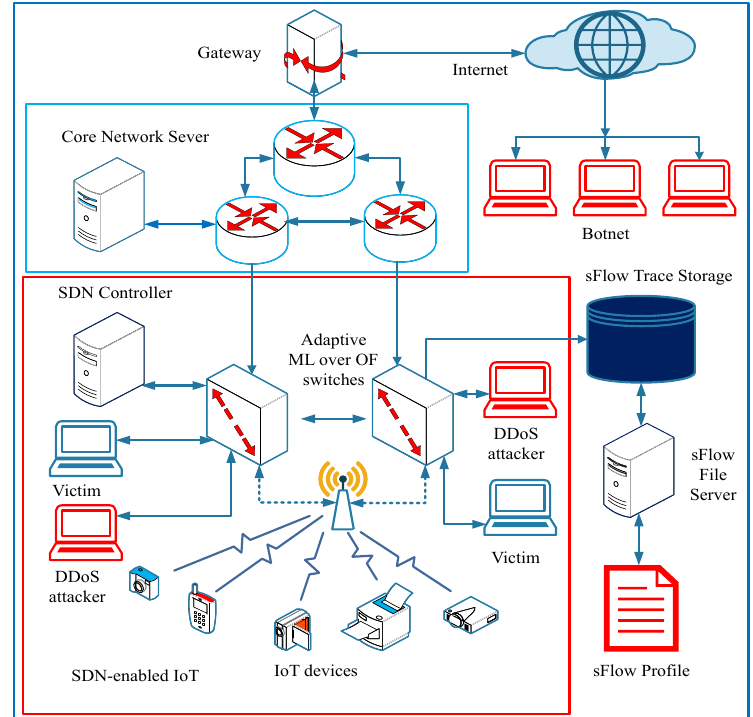
Figure 4. General network architecture to implement adaptive machine learning based DDoS